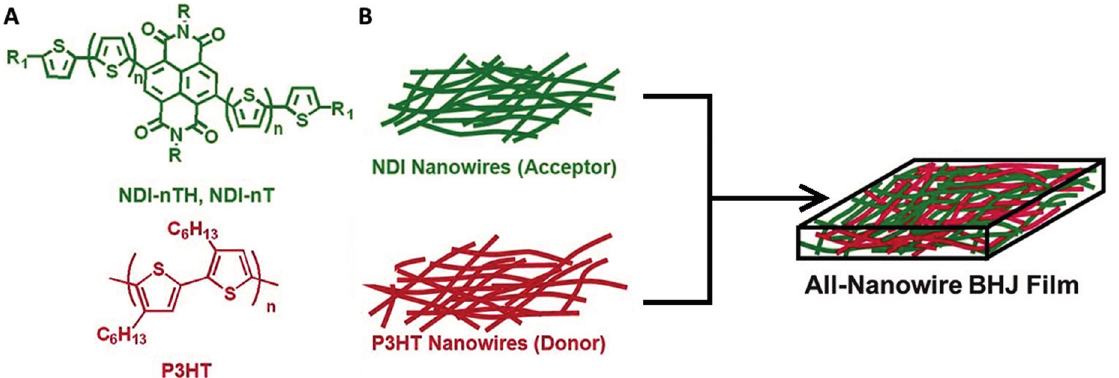
Figure 4. ( A ) Molecular structure of P3HT and NDI ( n = 1–3, R 1 = H or C 6 H 13 , R = ethylhexyl); ( B ) Schematic of an all-nanowire bulk heterojunction (BHJ) active layer. Adapted from [62] with permission from The Royal Society of